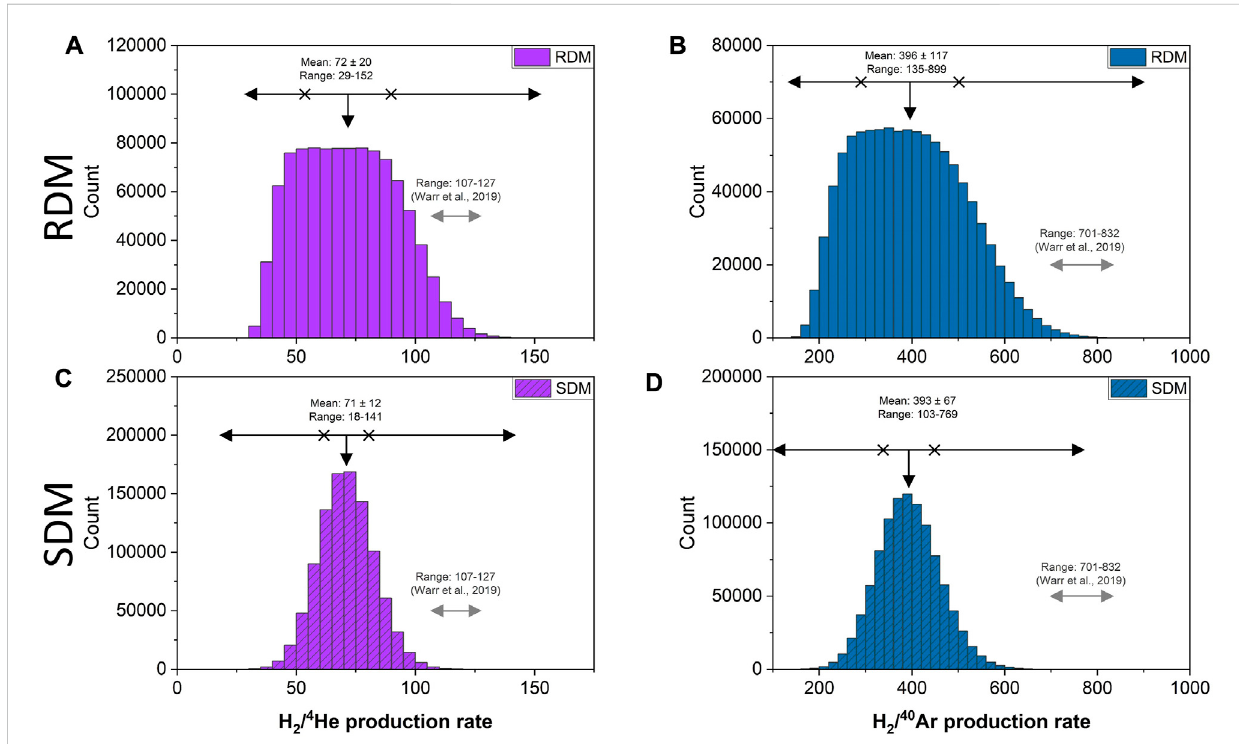
FIGURE 2 H 2 / 4 He and H 2 / 40 Ar production ratios determined via the RDM Monte Carlo approach (A,B) and the SDM Monte Carlo approach (C,D) respectively. Each ratio was derived per cycle based on production of H 2 , 4 He, and 40 Ar generated via the Monte Carlo approach to calculate the probabilistic distribution of H 2 / 4 He and H 2 / 40 Ar production ratios. As with Figure 1 the black horizontal arrows represent the range (maximum-minimum), the vertical arrows represent the average (mean), and the crosses represent the associated standard deviation (1 σ ). The range of previous ratios used in Warr et al. (2019) are plotted as grey horizontal arrows for